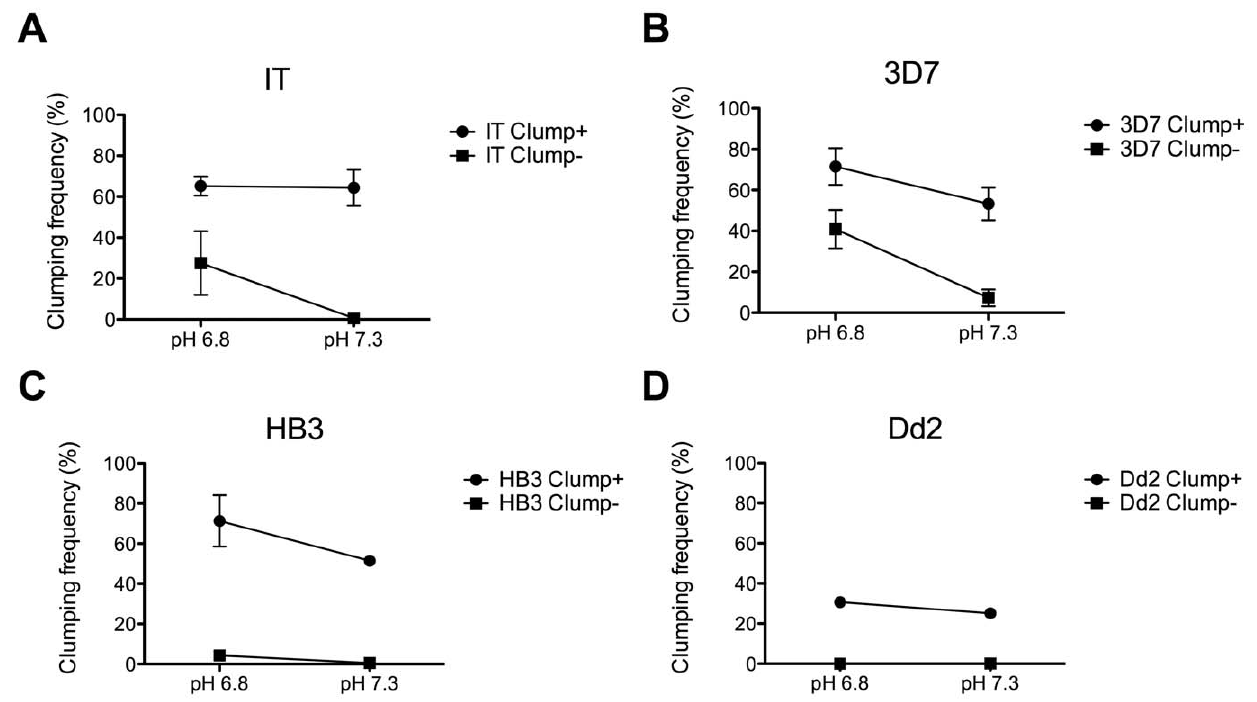
Figure 4. Effect of pH on platelet-mediated clumping of P.falciparum infected erythrocytes (IEs). Platelet-mediated clumping assays were set up at 10% Ht, 1% Pt, and 20% PRP, in binding medium at pH 7.3 or pH 6.8. The clumping frequency (CF, percentage of IEs in clumps out of 500 IEs counted) was assessed by fluorescence microscopy of two wet preparations at time point 1 h. Graphs show mean and SE of CF for each parasite strain. (A) IT (4 independent experiments), (B) 3D7 (6 experiments), (C) HB3 (2 experiments) and (D) Dd2 (2 experiments). The CF of 3D7 Clump 2 parasites showed a significant increase at pH 6.8 compared to 7.3 (p , 0.01, paired t test). Other comparisons were not significant.